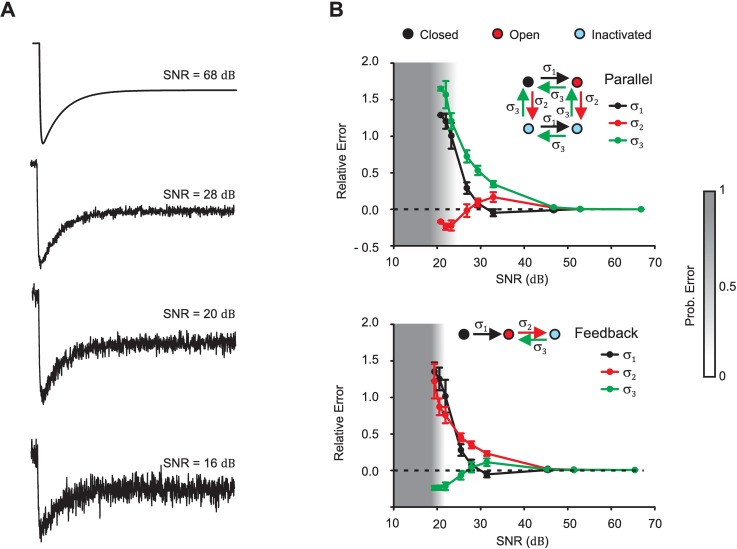
Effect of noise on kinetic parameters and probability of error in classification.(A) Representative traces of output signal y(t) used to test the effects of noise. Traces were generated with the Synthetic Trace Module (see Resultssection) combining two first-order processes with parameters ka = - 5, kb = 3, τa = 5 ms and τb = 100 ms in parallel with different levels of white Gaussian noise added. (B) Relative error in transition-rate kinetic parameters (σ1, σ2, and σ3) and probability of error in detection for parallel and feedback configurations. Each point in the graph depicts the mean and standard deviation of 100 simulations. Boundary conditions used in the Classifier Module are τa ∈ [1, 9] ms, τb ∈ [50, 250] ms, ka ∈ [−20, 20], and kb ∈ [−20, 20] for the parallel problem, and kb ∈ [0, 20] for the feedback problem since combinations in feedback with kb < 0 are unstable.